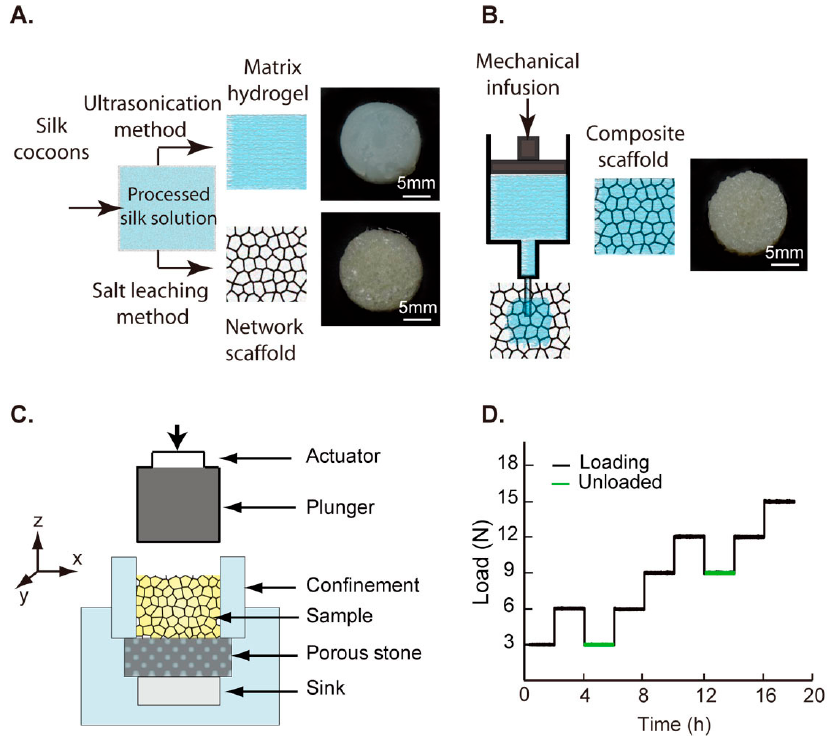
Figure 8. ( A ) Fabrication routes used for preparation of matrix and network samples, with